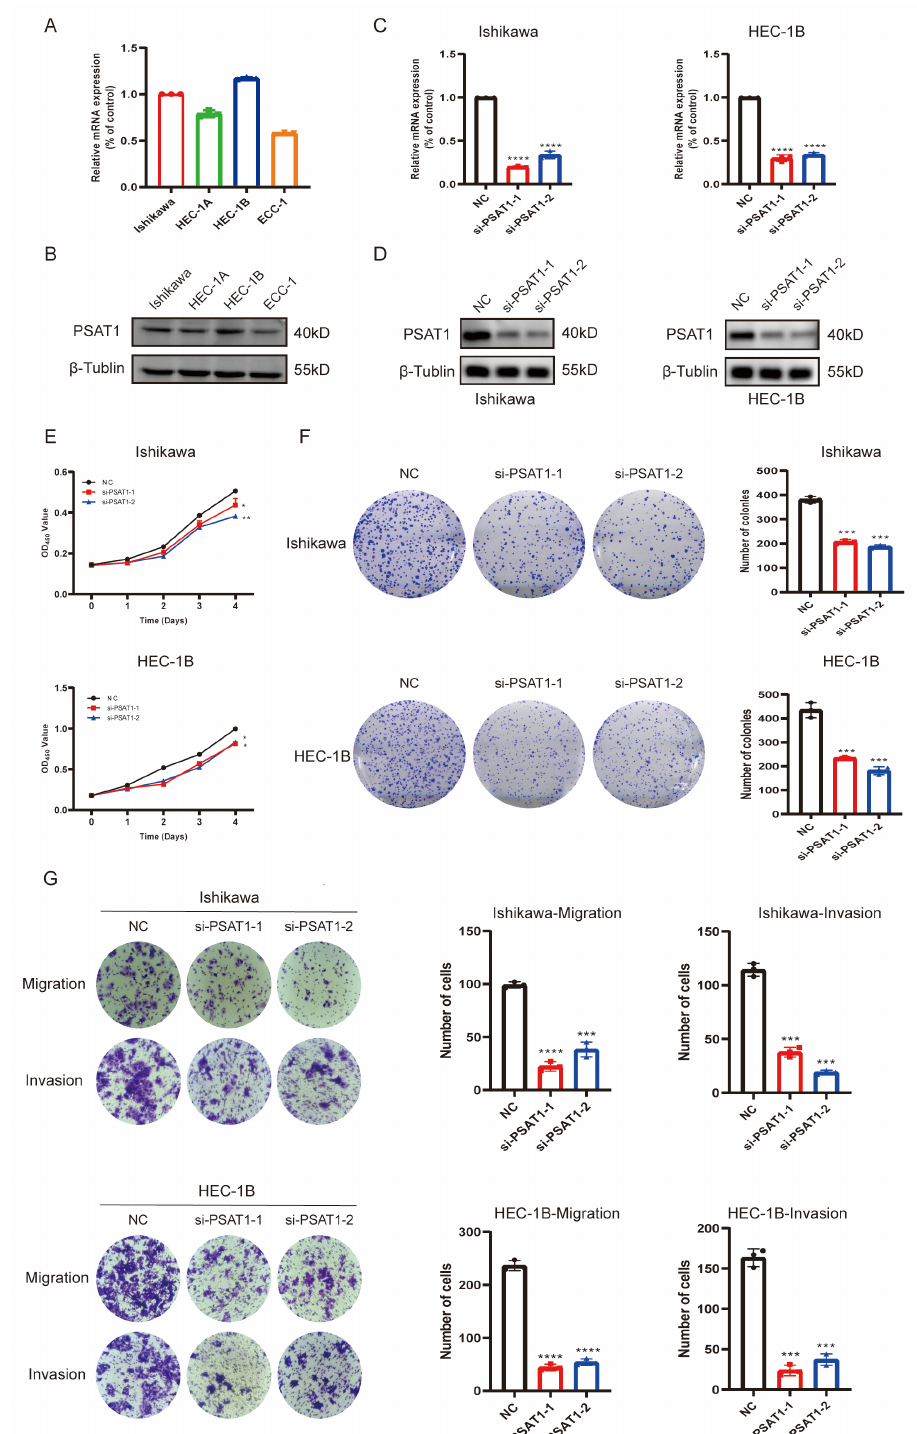
Figure 7. The risk gene PSAT1 promotes UCEC cells’ proliferation, migration, and invasion. ( A , B ) mRNA and protein levels of PSAT1 were measured by qPCR and Western blotting in four UCEC cell lines. ( C , D ) The efficiency of the knockdown of PSAT1 in Ishikawa and HEC-1B cells were measured by qPCR and Western blotting. ( E , F ) CCK-8 and colony formation assays showed that the proliferation ability of UCEC cells was decreased after PSAT1 knockdown. ( G ) The transwell assay showed that the migration and invasion capacities of UCEC cell lines were inhibited after PSAT1 knockdown. * p < 0.05, ** p < 0.01, *** p < 0.001, **** p < 0.0001.